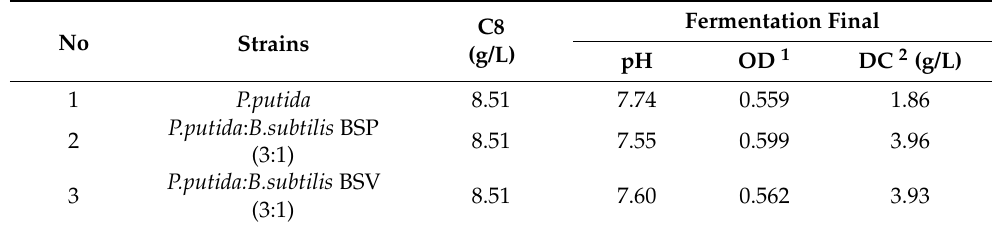
Table 3. Fed-batch fermentation for PHA biosynthesis. Reprinted with permission from ref. [68], 2016, Eremia et al., Ovidius Univ. Ann. Of Chem.